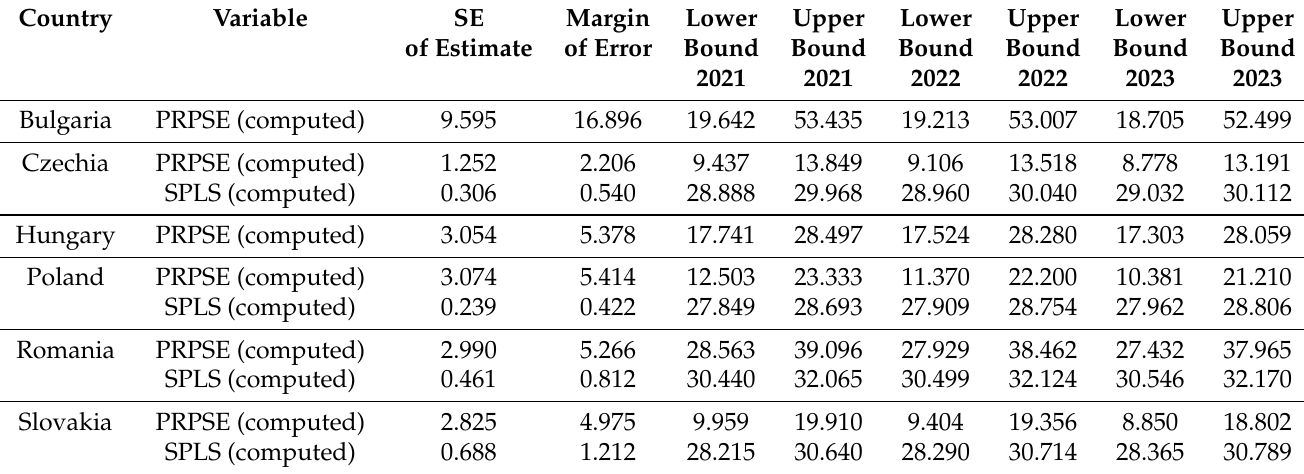
Table 7. The lower and upper bound of the confidence intervals for PRPSE and